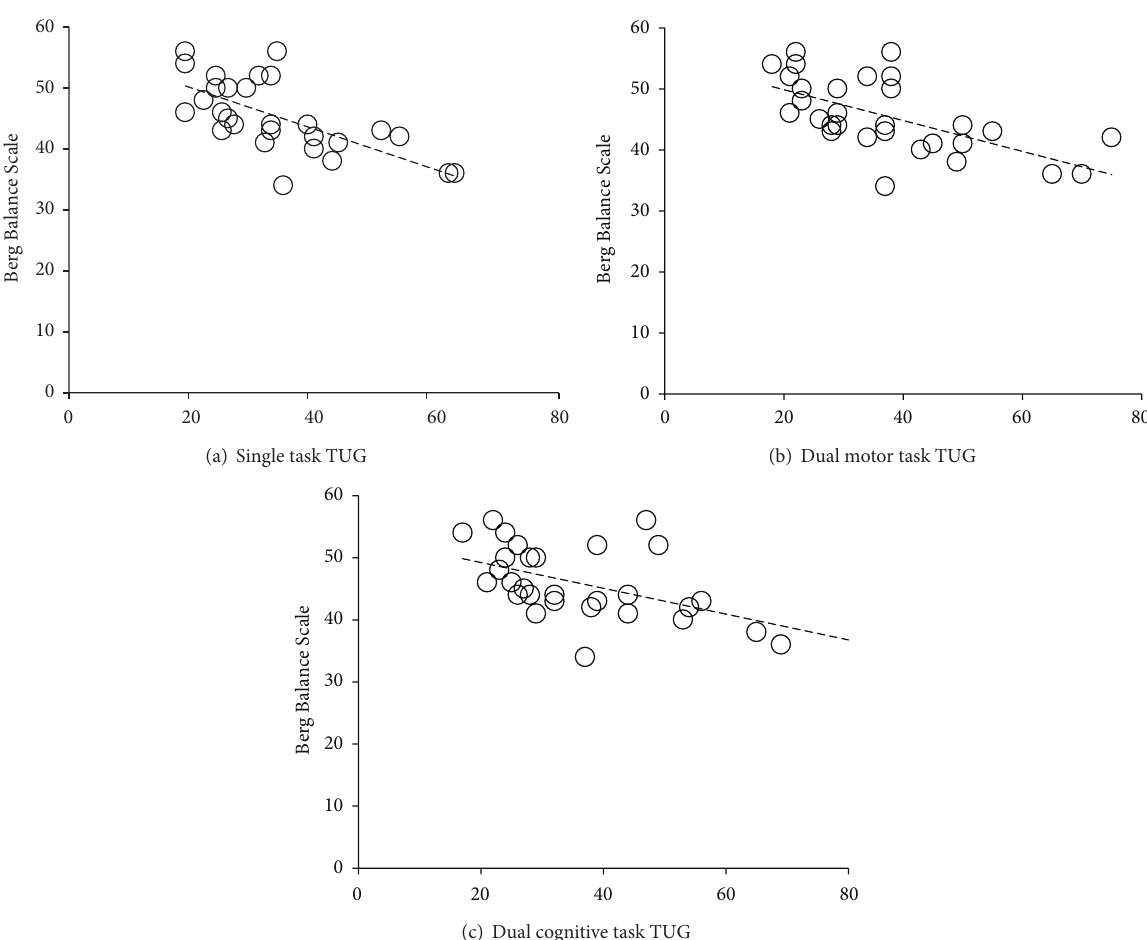
Figure 4: Scatter plots between Berg Balance Scale (BBS) scores and number of steps to complete Timed Up and Go (TUG) test across three attentional loading conditions. (a) Single task TUG, (b) dual motor task TUG, and (c) dual cognitive task TUG.